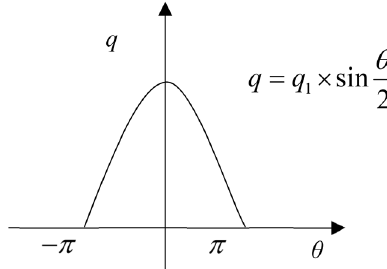
Figure 1. Sine function curve of rust force.